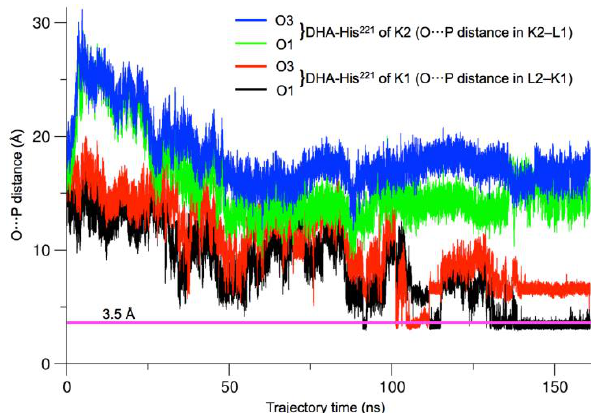
Figure 12. Evolution of the DHA-to-ATP distance in the hTKFC:2DHA:2ATP trajectory. Distances were measured in the full 160-ns trajectory between each of the hydroxyl oxygens of DHA (the trihydroxyprop-2-yl radical covalently bound to His 221 ) and the γ -phosphorus of ATP in the same site (i.e., L2-K1 and K2-L1). The pink line marks the 3.5 Å distance. The first 75-ns of this trajectory have been reported in earlier work [2].